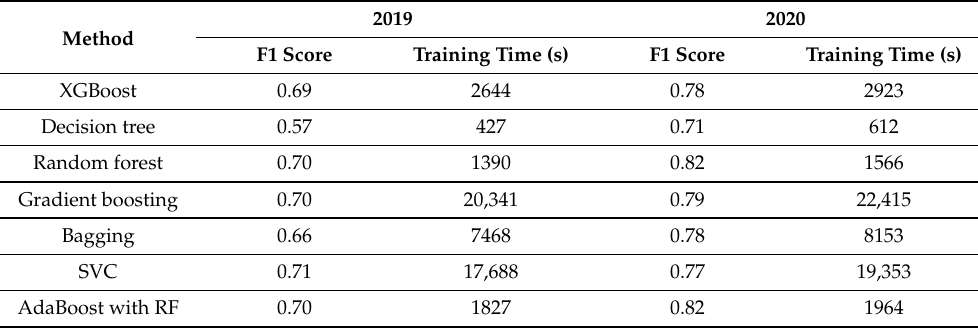
Table 7. Comparison of the F1 scores and training times obtained for different classical ML methods for 2019 and